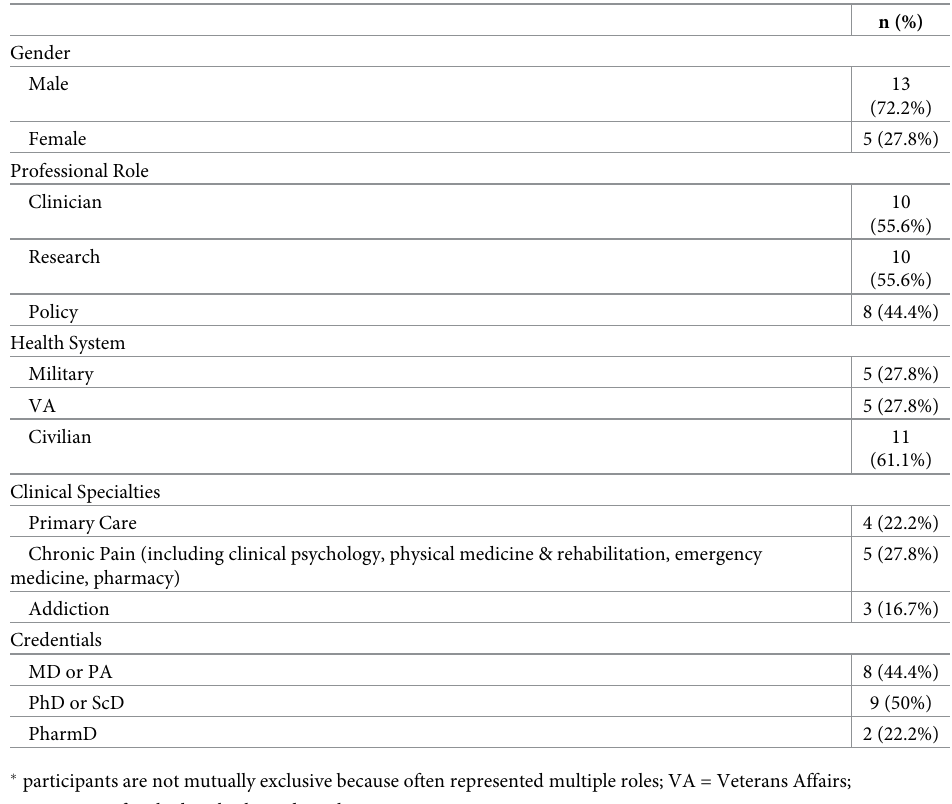
Table 1. Participant sample characteristics (N = 18) �